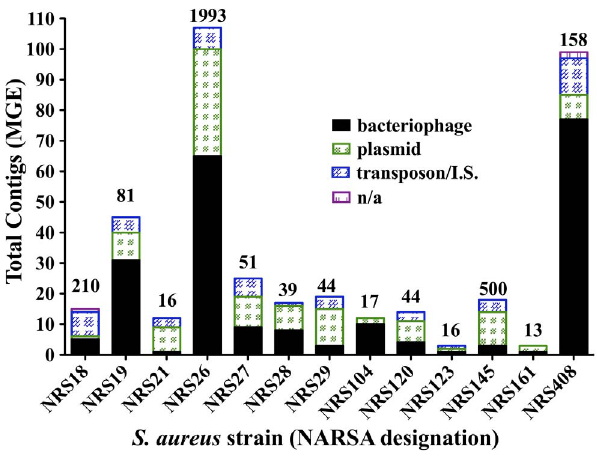
Figure 2. Identification and classification of contig sequences that contain phage genes and other genetic elements from S. aureus extra-chromosomal DNA. BLAST nucleotide sequence analysis identified the sequence identity of contigs generated from S. aureus extra-chromosomal DNA. Contigs were labeled based on homology to published nucleotide sequences: bacteriophage (black), plasmid (green), transposon/insertion sequences (IS) (blue), or not in GenBank database (n/a; purple). Contigs were labeled transposon/(IS) if a transposon or insertion element was unassociated or associated with plasmid or chromosome. Numbers above rectangular bars represent the total contigs within an individual sequencing sample. Y-axis lists total contigs identified as mobile genetic elements (MGE) based on BLAST homology identifications. affect its DNA, indicating that it was in fact circular (Figure S3A in